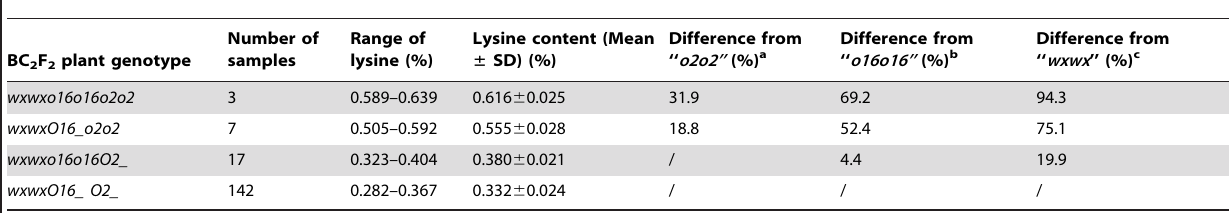
Table 6. Lysine content of BC 2 F 3 seeds from four recessive genotypes in BC 2 F 2 .